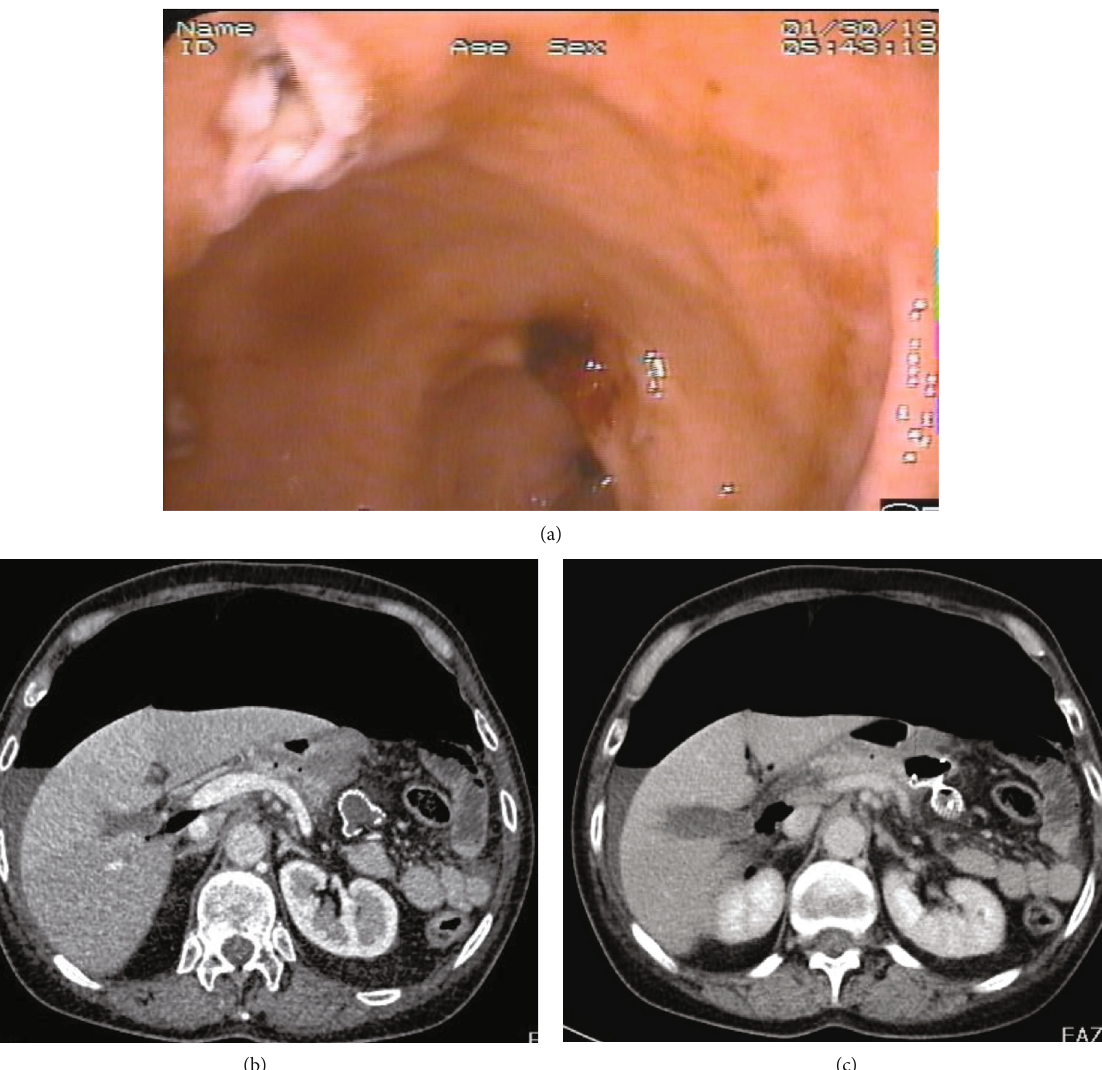
Figure 13: (a – c) Early proximal transmural stent migration. (a) The endoscopic image shows the transmural fi stula without the stent. (b, c) Contrast-enhanced multiphase computed tomography image of the abdominal wall in a patient su ff ering from a perforation of the gastrointestinal tract due to early proximal dislocation of the transmural stent. (b, c) A large amount of air can be seen in the peritoneal cavity, as well as the dislodged transmural stent outside of the gastrointestinal